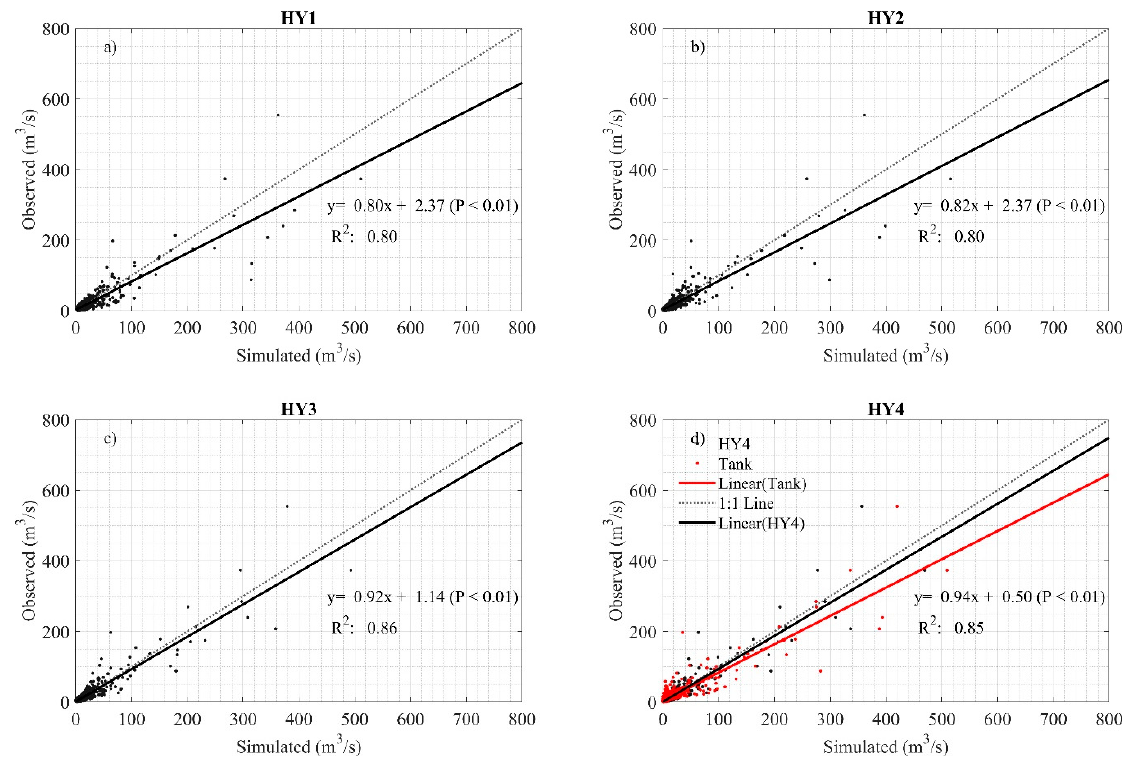
Figure 11. Scatterplots of the observed and simulated runoff over the testing period. The dotted lines represent perfect linear relationships, while the solid black lines indicate a linear fit between the simulated and observed runoff. The result of the tank model simulation is displayed with the solid red line in panel (d).